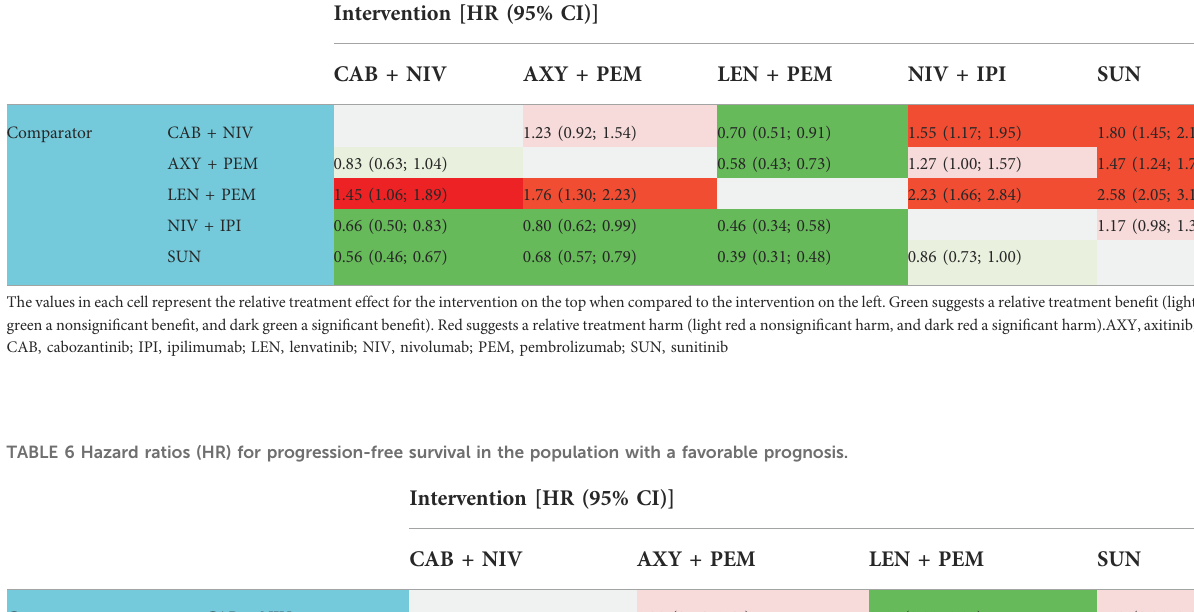
TABLE 5 Hazard ratios (HR) for progression-free survival in the overall population.